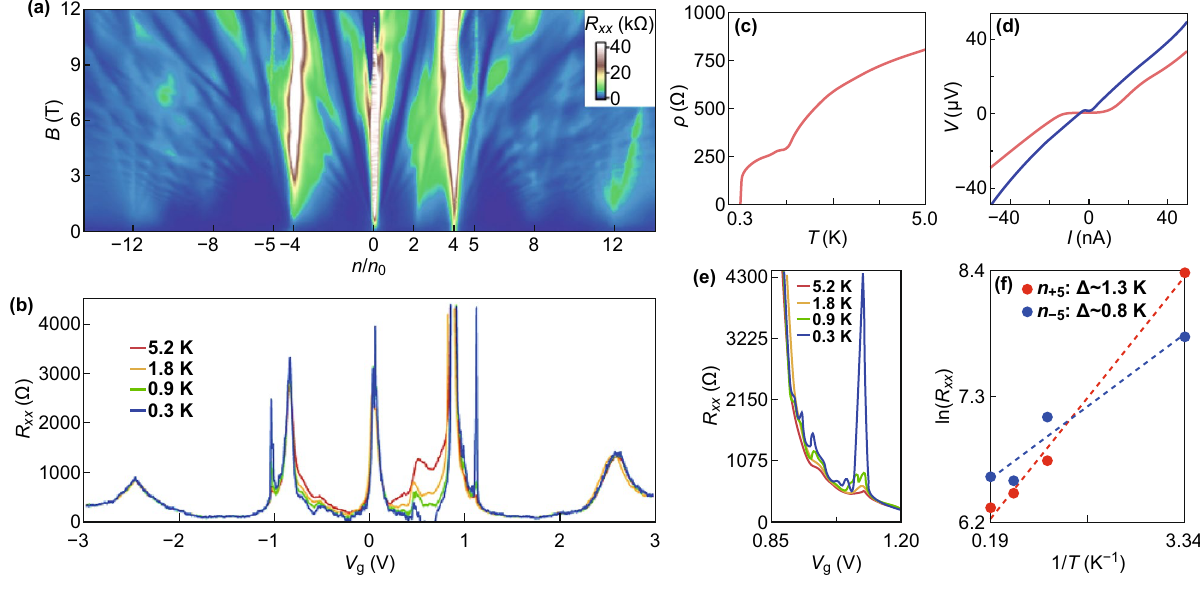
Fig. 10 a R xx versus magnetic field B and gate voltage V g , showing a Landau fan pattern. b R xx ( V g ) at different temperatures. c ρ versus tempera- ture when the density is tuned to the superconducting phase. d Voltage–current characteristics at T = 280 mK and V g = 0.58 V (red) and 0.50 V (blue). e Temperature dependence of the resistance peak. f Arrhenius plot of resistance [144]. Adapted with permission from Ref. [144]. (Color figure